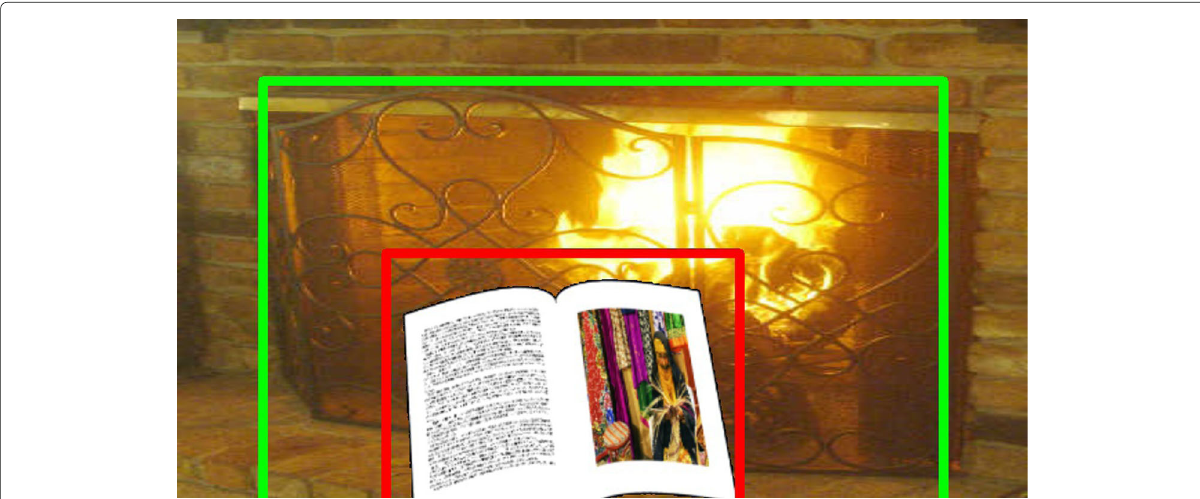
Fig. 5 Bounding region (green rectangle) for book image